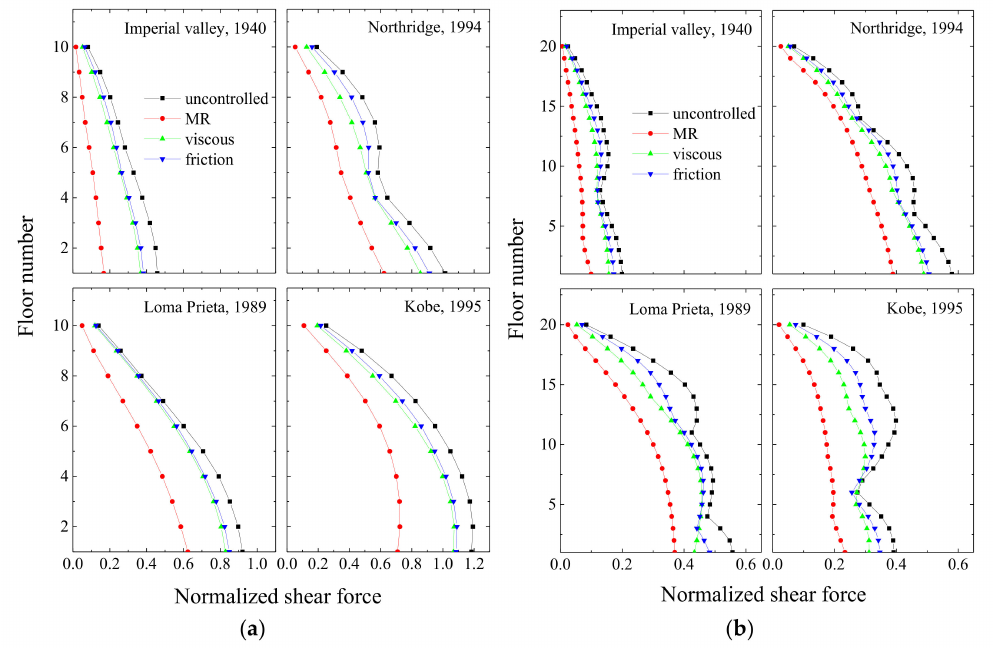
Figure 19. Peak normalized storey shear response of: ( a ) a coupled stiff building and ( b ) a coupled flexible building when they are connected with different types of dampers arranged in Configura- tion 1. Table 5. Comparison of top storey peak acceleration of the coupled stiff building under different control strategies when dampers are arranged in Configuration 1.